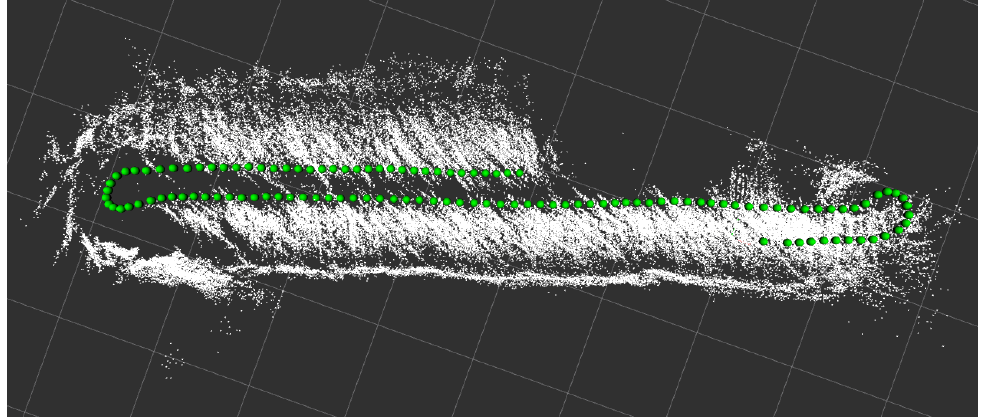
Figure 10. Laser scanning-based 3D point cloud with the path travelled by the tractor in green